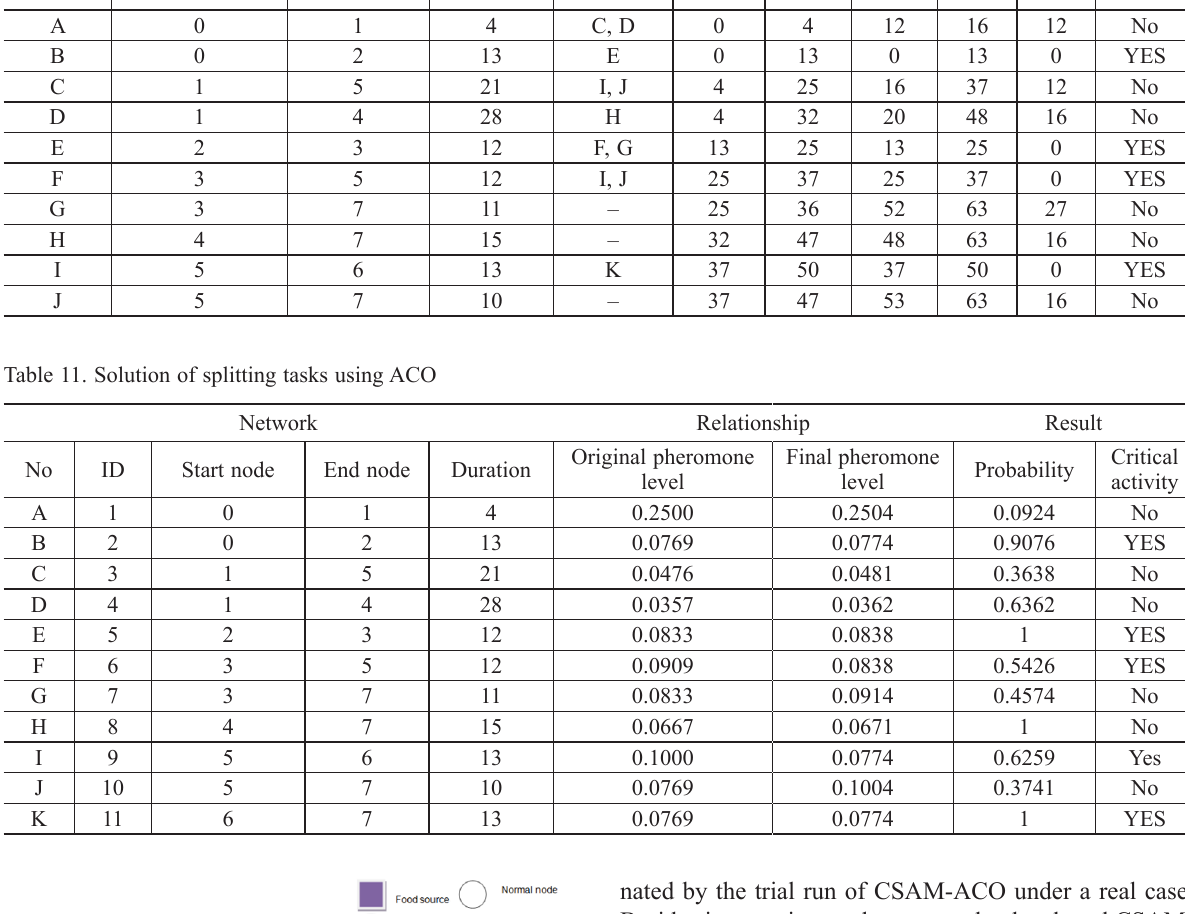
Table 10. Solution of new critical path for splitting tasks using CPM Code